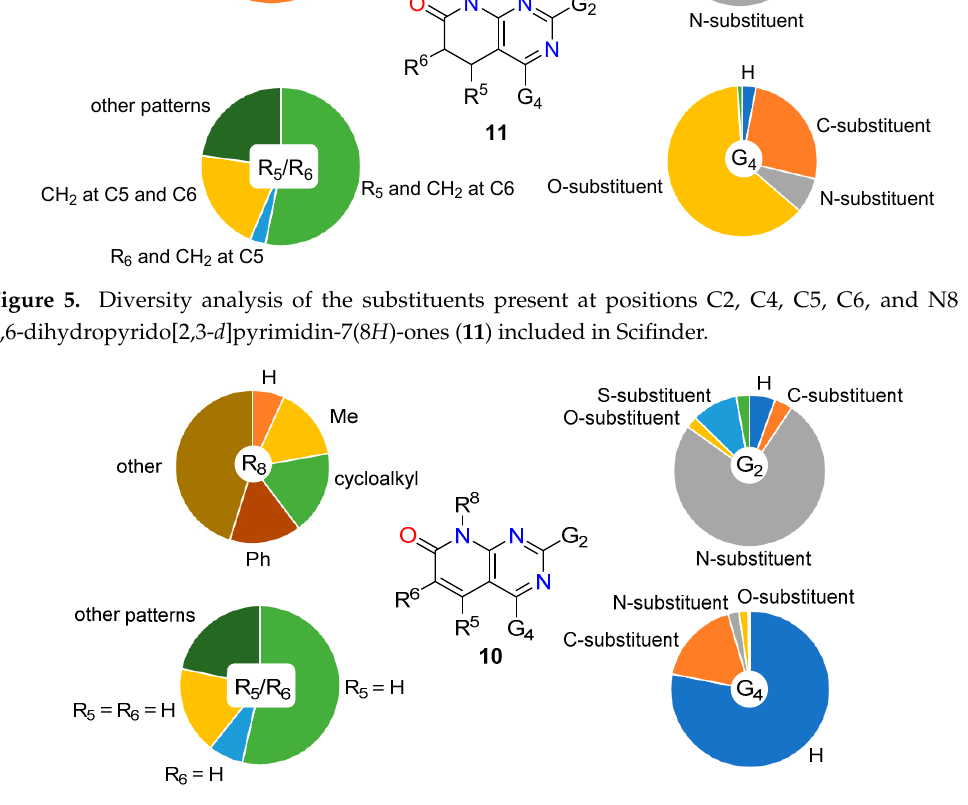
Figure 6. Diversity analysis of the substituents present at positions C2, C4, C5, C6, and N8 of pyrido[2,3- d ]pyrimidin-7(8 H )-ones ( 10 ) included in Scifinder .